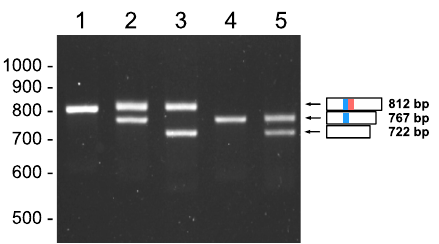
Figure 1. Agarose gel electrophoresis patterns of e HRG polymorphisms. The HRR of e HRG was amplified by PCR using genomic DNA extracted from the leukocytes. The PCR products were separated on 2% agarose gel and stained with ethidium bromide. Five amplifying band patterns consisting of three bands of different lengths were detected. Lanes 1 and 4: homozygous genotypes; lanes 2, 3, and 5: heterozygous genotypes. The photo represents a typical image obtained from the PCR experiments of 1700 Thoroughbred